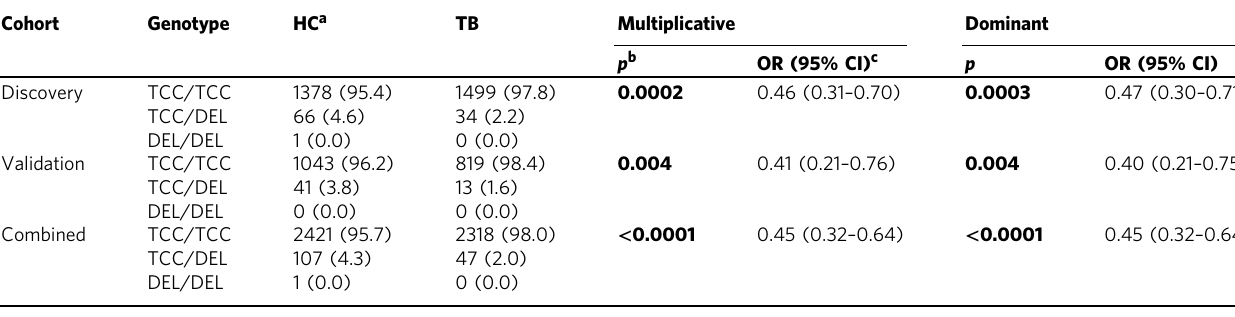
Table 1 Association of IFNAR1 rs72552343 and tuberculosis susceptibility Cohort